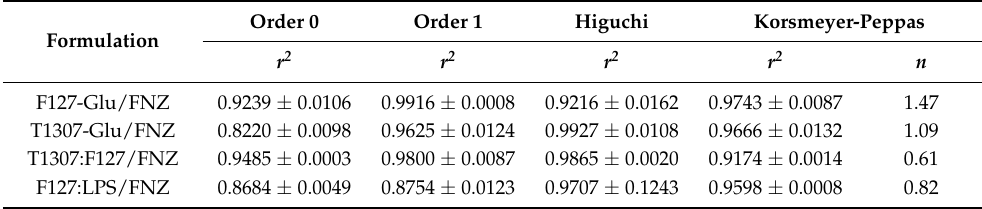
Table 2. Kinetic model fits for in vitro FNZ release from the nanoformulations.